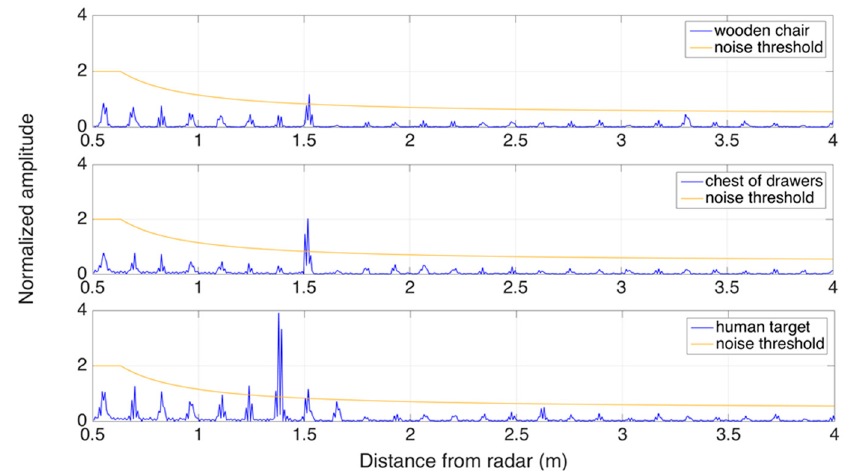
Figure 8. Intermediate frequency (IF) signals obtained from obstacles at the range of 1.5 m. From the top to bottom, results are shown for a wooden chair, a chest of drawers, and a human target [23].